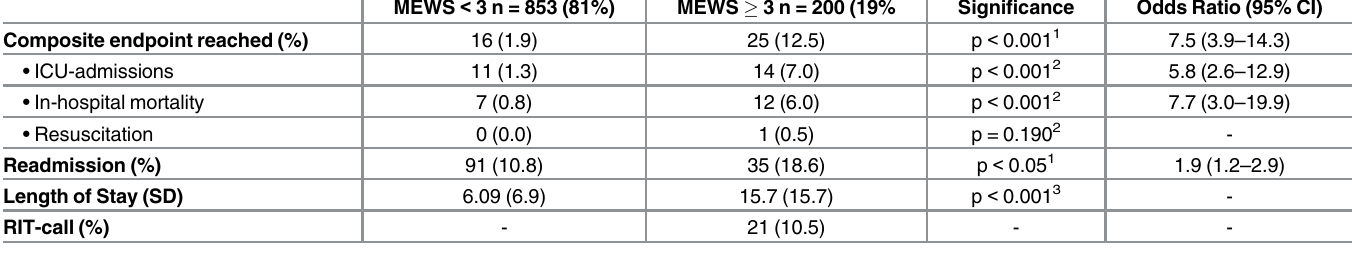
Table 2. Patient